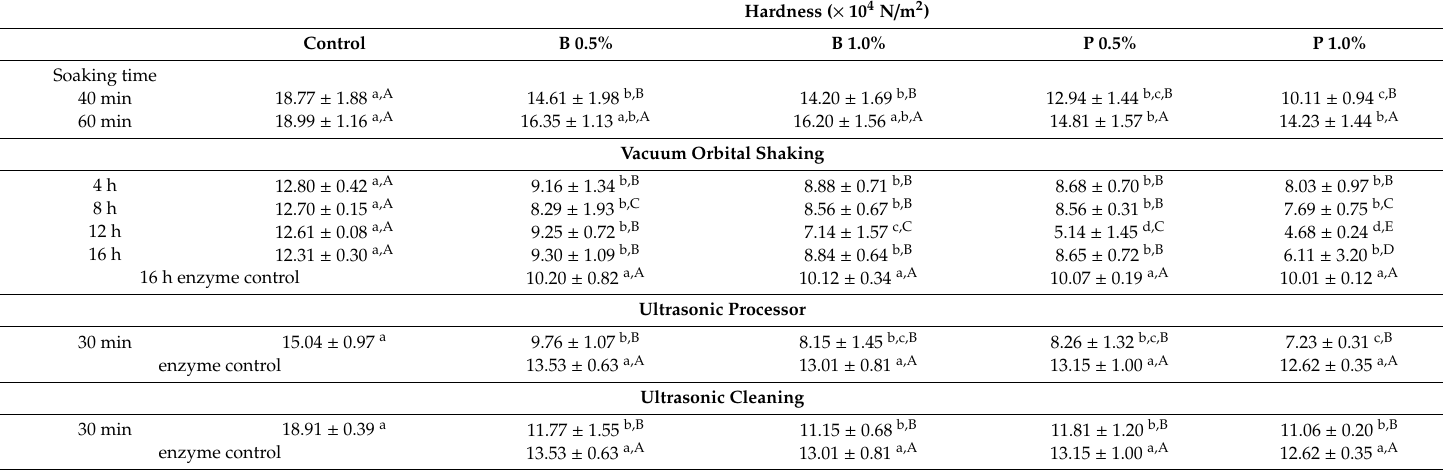
Table 2. Hardness of neritic squid muscle soaked in bromelain (B) and papain (P) enzymes and subjected to various treatments, versus untreated controls.